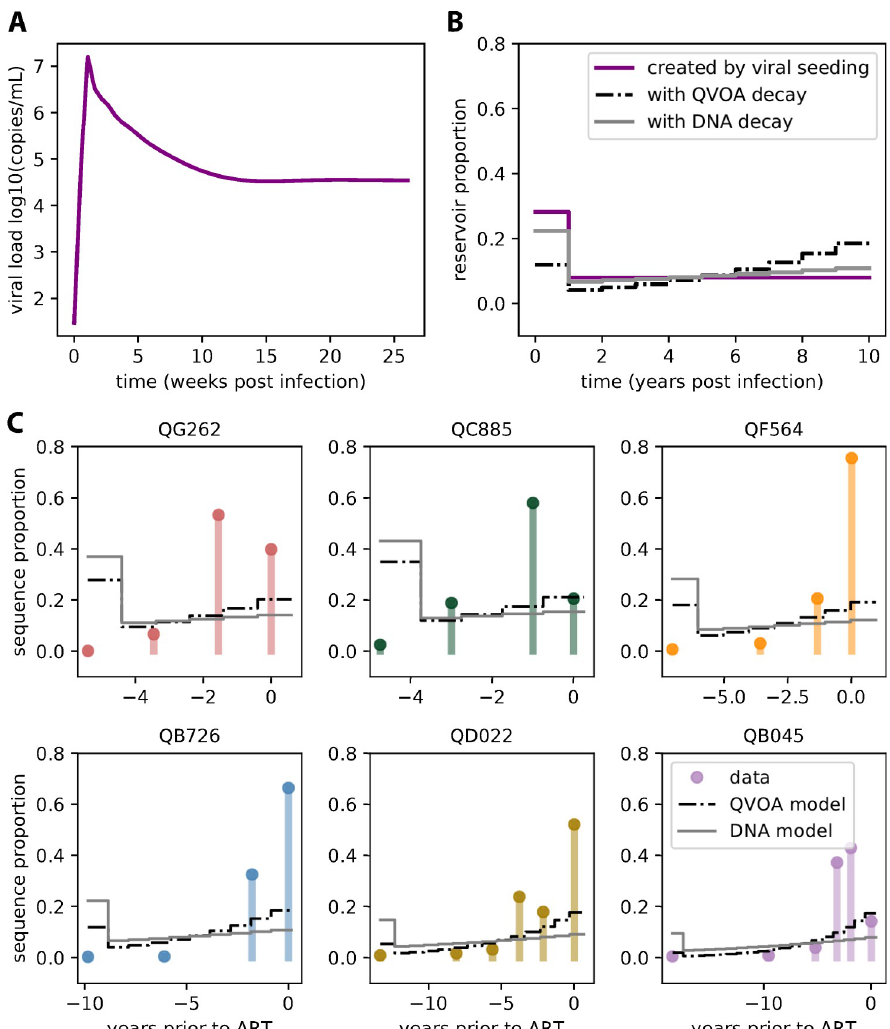
Fig 5. Modeling reservoir creation with constant seeding and decay. (A) A mechanistic mathematical model was used to generate a representative viral load curve. (B) A model of the proportion of cells seeded in the reservoir during each year of infection (purple line) based on the assumption that sequences entered the reservoir in proportion to the viral load dynamics shown in panel A. The model predicted that the highest proportion of reservoir sequences were created during the first year of infection because peak viral load is ~2 logs higher than viral load set-point (see A). We then added a constant decay rate of a 44-month half-life (based on QVOA measurements from Siliciano et al [8]) to the model and plotted the proportion of sequences contributing to the reservoir from each year (dashed black line) over a 10-year simulated infection. This “cumulative” constant seeding and decay model resulted in a bias to sequences created later during infection. This effect is lessened when we used a slower decay rate of 140 month half-life based on total HIV DNA decay [10] (solid grey line). (C) Comparisons of cumulative models to the experimental proportions of gag sequences estimated to contribute to the reservoir from each year of infection in 6 individuals. Models based on a half-life of 44 months (dashed black line) or 140 months (grey line) differ with length of infection. Experimental data suggests the reservoir is comprised of a larger number of sequences created near the time of ART initiation than would be expected from models using either clearance half-life. The accuracy of the model to the data was quantified using a non-parametric Kolmogorov-Smirnov test and was significant for all individuals (p < 0.01 for all subjects, see S5 Fig) using either half-life model, confirming that the constant seeding and continuous decay model is unlikely to explain the observed